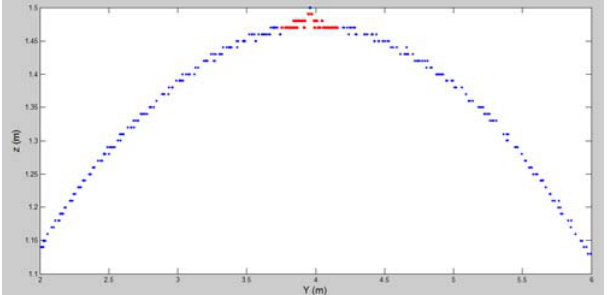
Figure 7. Example of transversal profile.